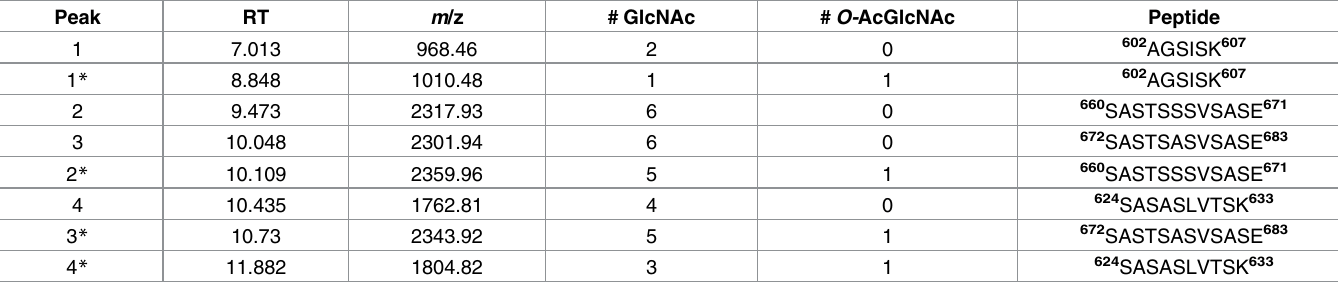
Table 1. List of GspB736flag glycopeptides identified by Q-TOF